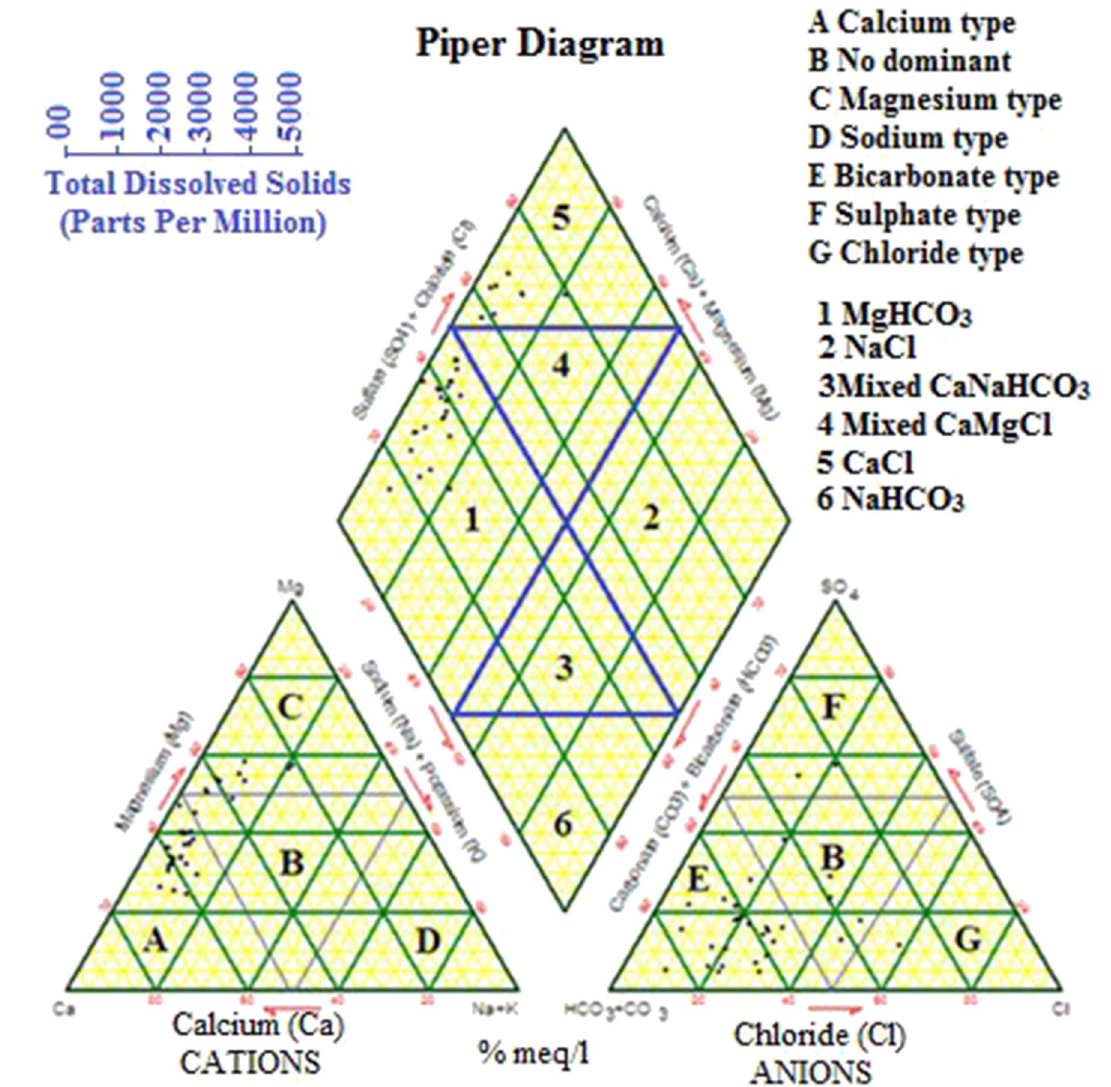
Fig. 5 Piper classification diagram illustrating the chemical composition of groundwater in